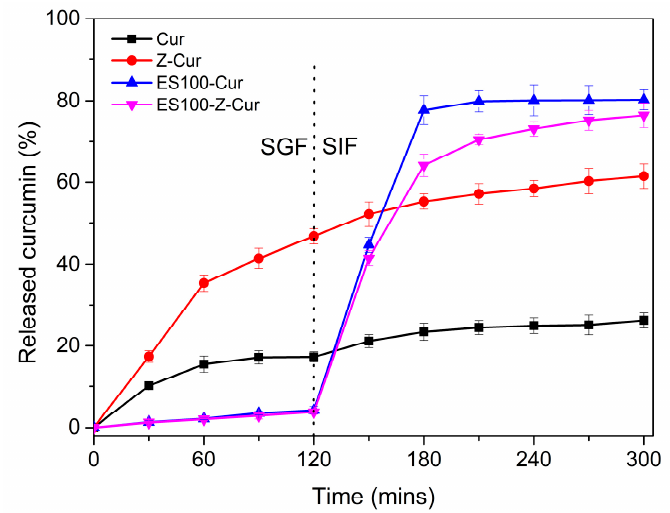
Figure 8. In vitro release of Cur from pure Cur, released self-assembled Z–Cur, ES100–Cur, and ES100–Z–Cur. Error bars represent the standard deviation.